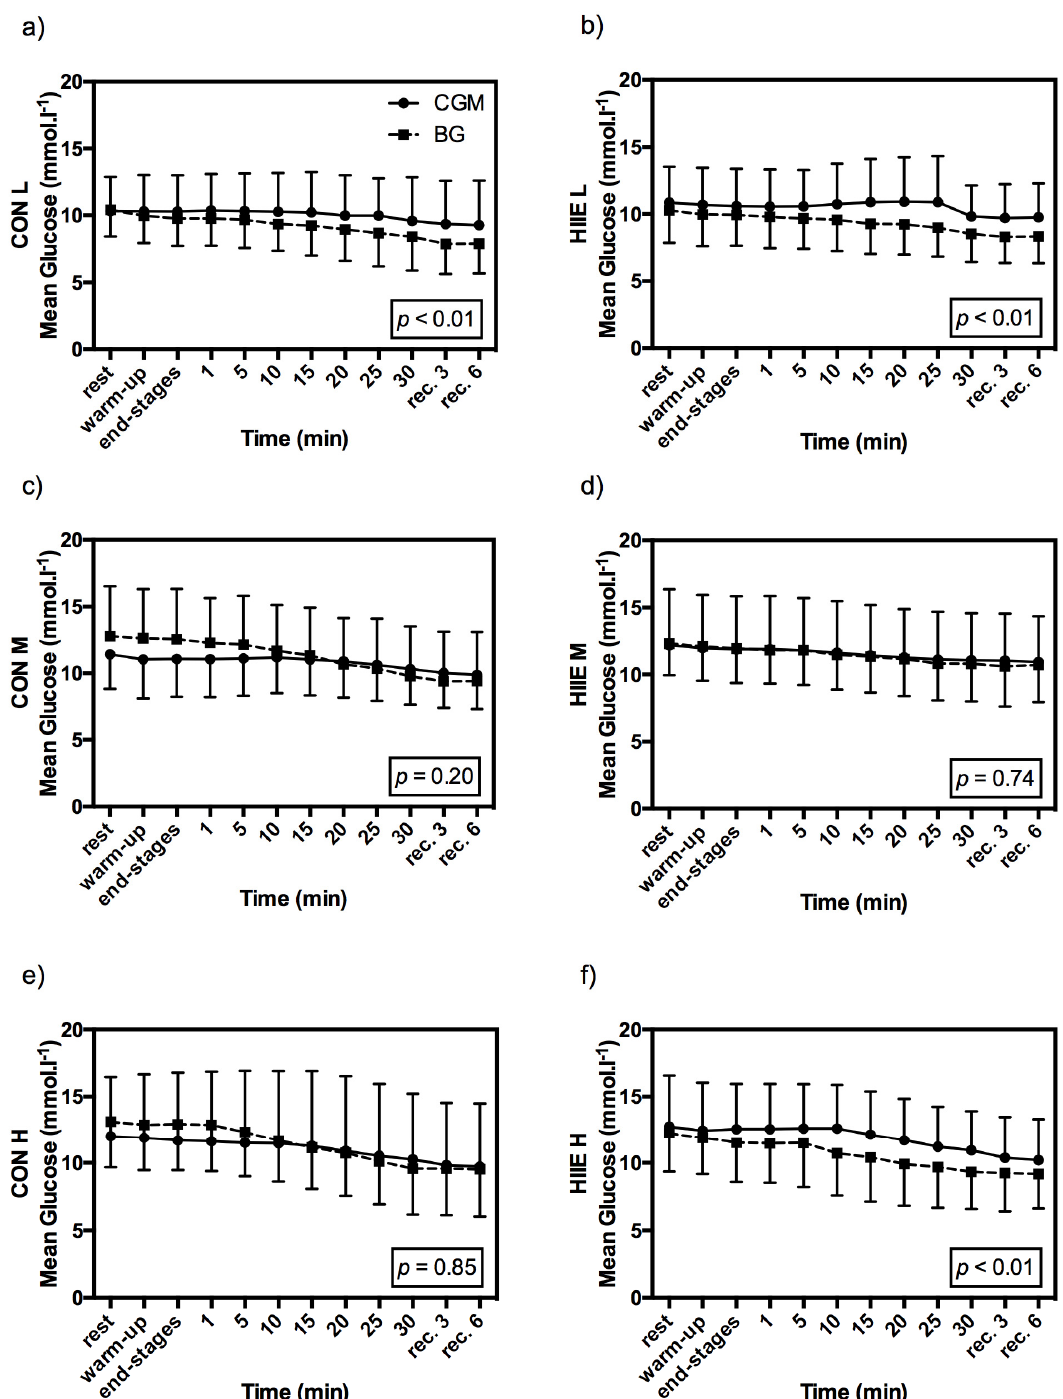
Figure 3. Glucose response from CGM (full line) and BG (dotted line) during CON and HIIE for the three standardized mean exercise intensities given as mean ± SD: CON for exercise intensities L ( a ), M ( c ), and H ( e ); as well as HIIE for exercise intensities L ( b ), M ( d ), and H ( f ). p -values are given for the comparison of mean BG and mean CGM.